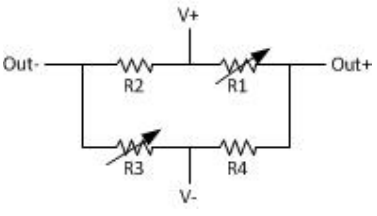
Figure 3. Wheatstone bridge